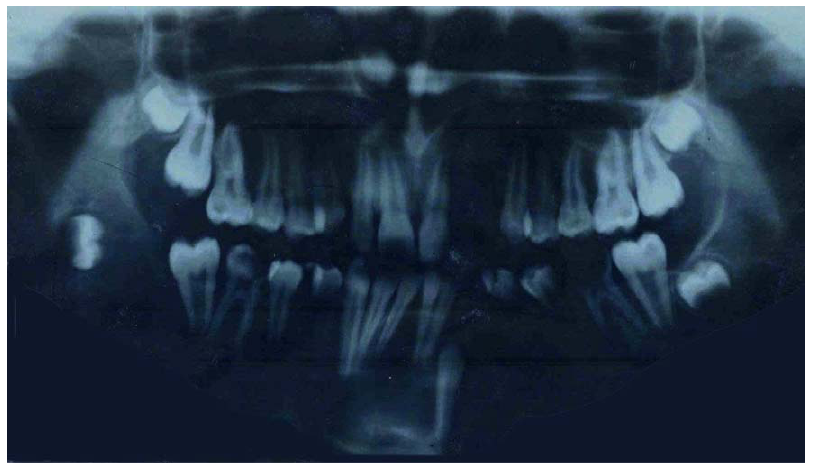
Figure 2. Dental Orthopantomography of a patient affected by NBCCS. (Patient n.11 of table 2).